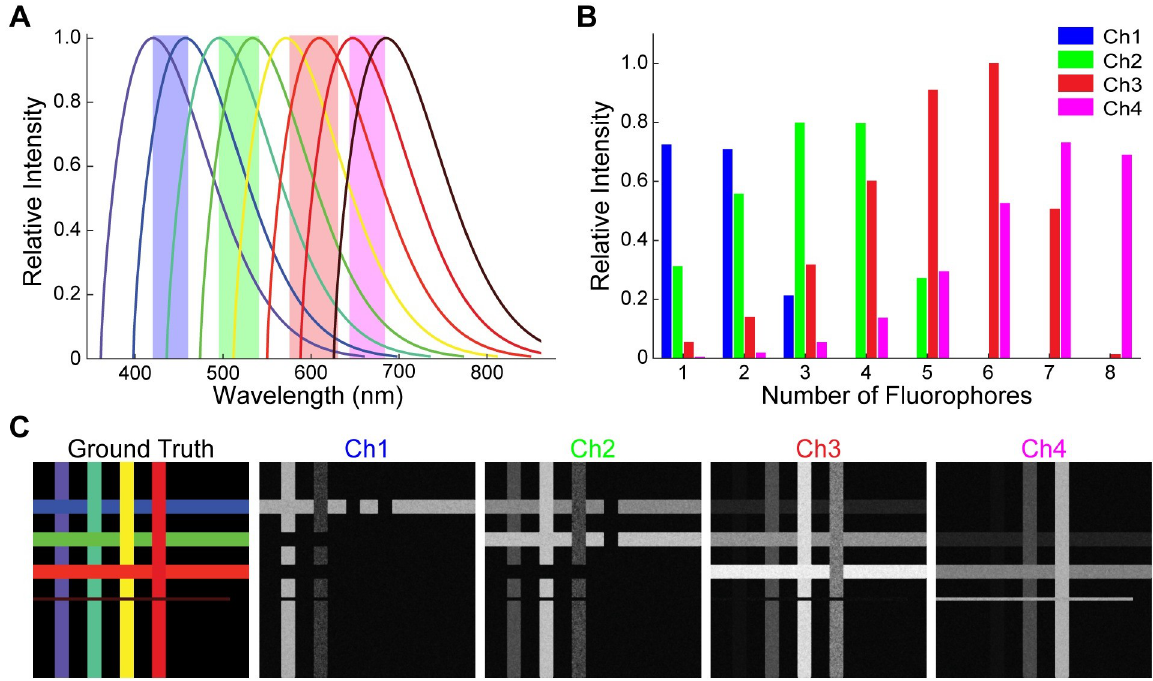
Fig 2. Synthetic data. (A) Synthetic emission spectra of 8 fluorophores. Bandwidth of the 4 detection channels were marked in shaded areas. For simplicity, the emission spectra of synthetic fluorophores were assumed to be the same Weibull distribution with the peaks of all fluorophores evenly distributed between 420nm and 685nm. (B) Spectral signatures of the 8 synthetic fluorophores in A. The intensity of each fluorophore was measured as the integrated area under the spectral curves in A. (C) Synthetic 2PLSM images based on the emission spectra in A. The ground truth image shows the 8 synthetic fluorophore expressing structures. Ch1-Ch4 images were the raw images from the 4 detection channels with an SNR of 10. Each fluorophore was synthetized to be expressed in a narrow band either vertically or horizontally. 7 of the 8 bands had the same area, while 1 small band (furthest red fluorophore) has an area 1/5 th (cluster size ratio 0.2) of the rest.